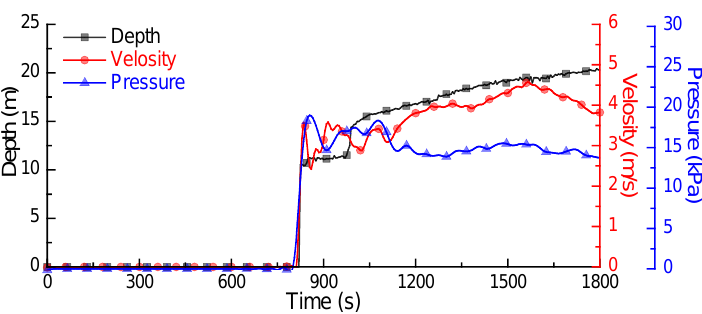
Figure 9. Numerical results of submerged depth, velocity and impact pressure at Bento Rodriguez.